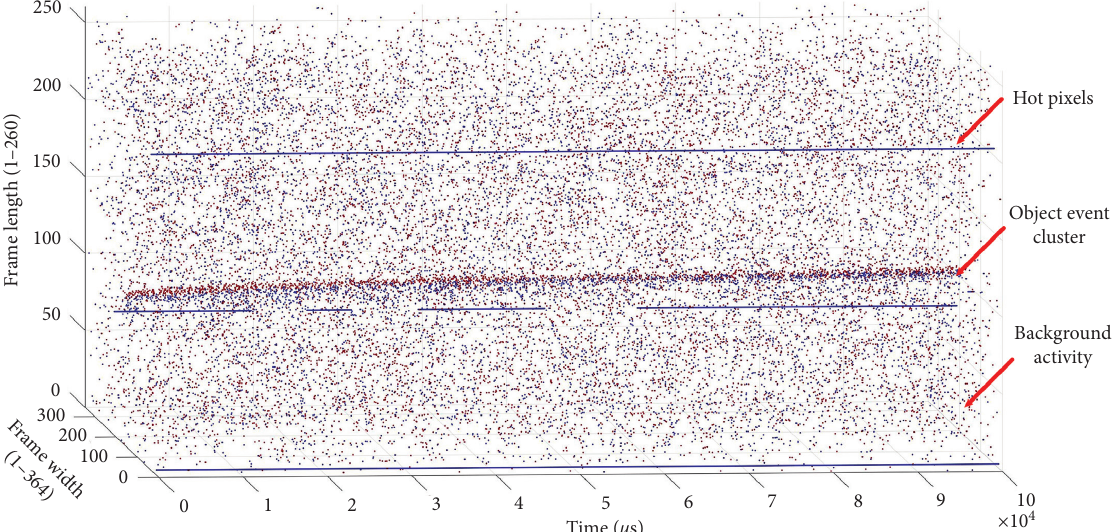
Figure 2: Three-dimensional scatter plot of moving object event stream. The horizontal dense event cluster is formed by the object movement. There is also hot pixel and background activity in event stream, which is marked in the figure. Hot pixels are blue lines, which are generated by pixels that send events incorrectly all the